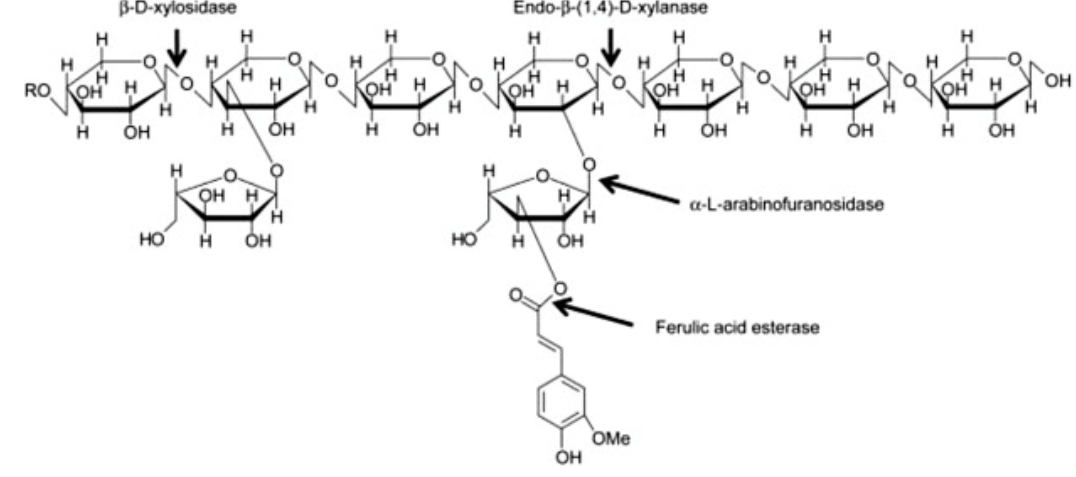
Figure 2. Structure of arabinoxylan [62].